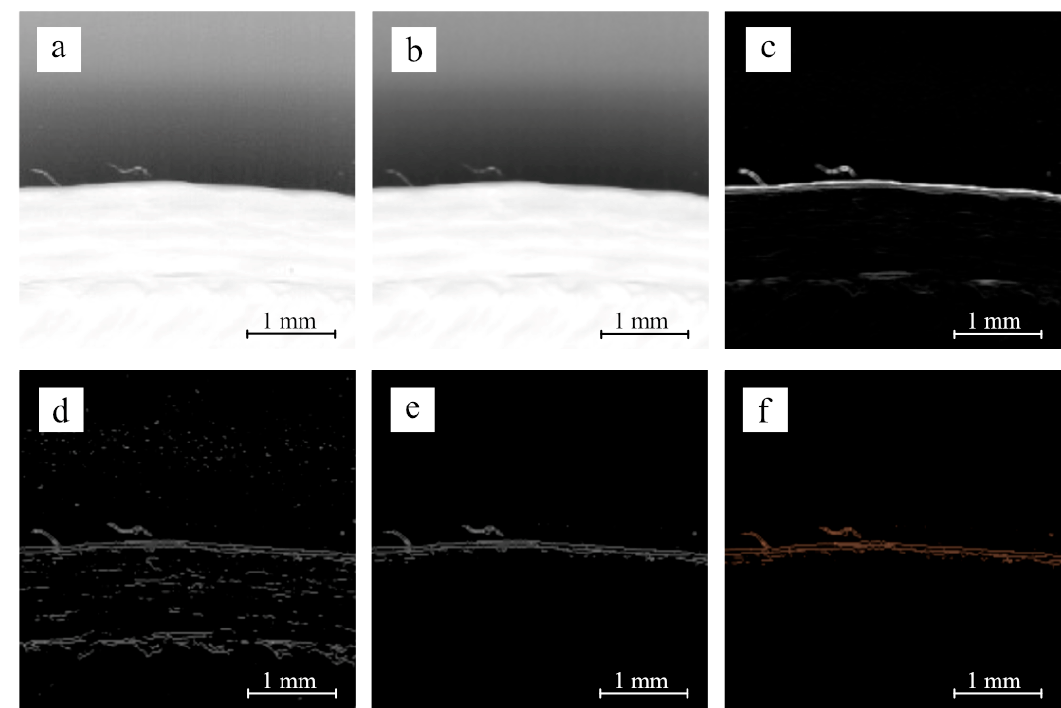
Figure 4. Generalised example of consecutive steps in image processing: ( a ) raw image or 𝐼0𝑥 ; ( b ) image after median filter; ( c ) image after applying differential operator; ( d ) image after thresholding; ( e ) image after annular cropping; ( f ) image ( 𝐽0𝑥 ) after LDA compensation.